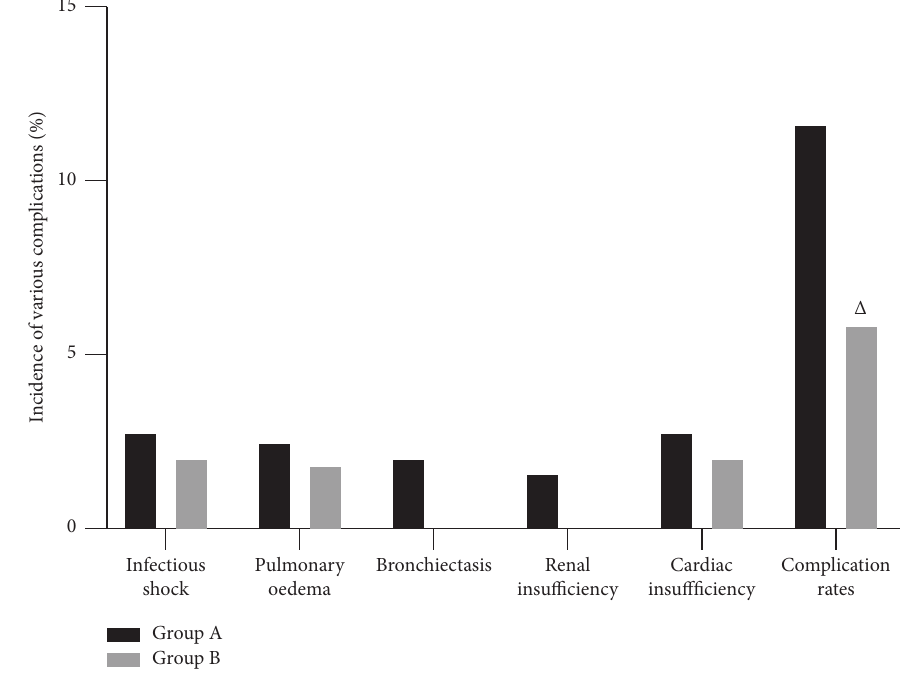
Figure 4: Incidence of various complications. Note . Comparison with group A △ P < 0 .